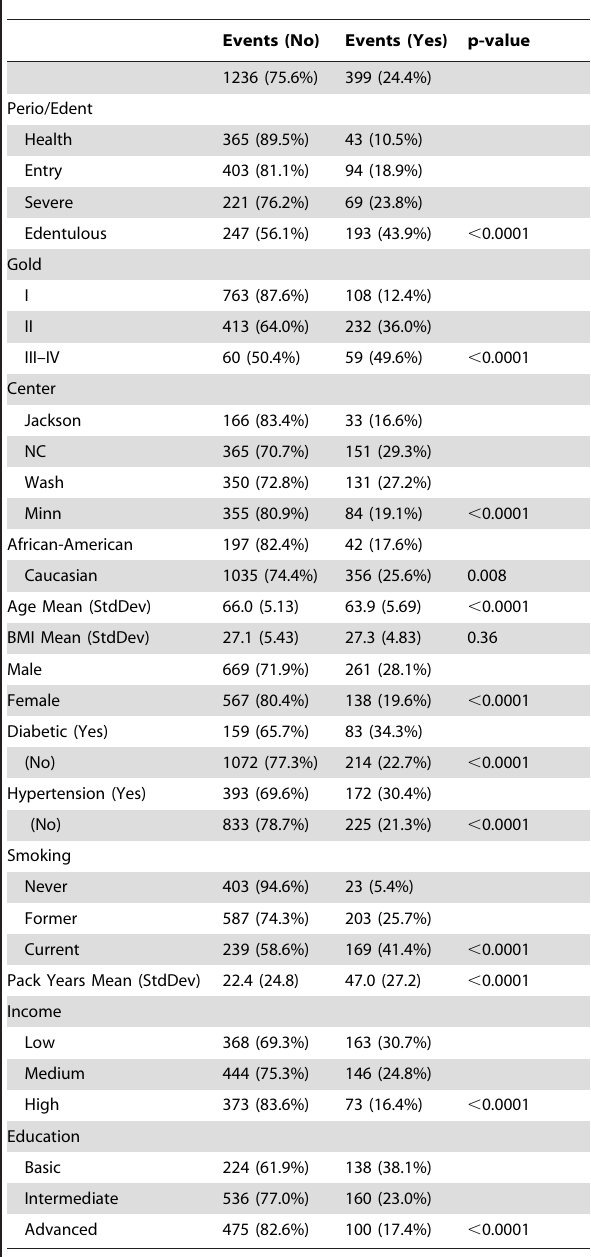
Table 3. Potential Explanatory Variables by COPD Related